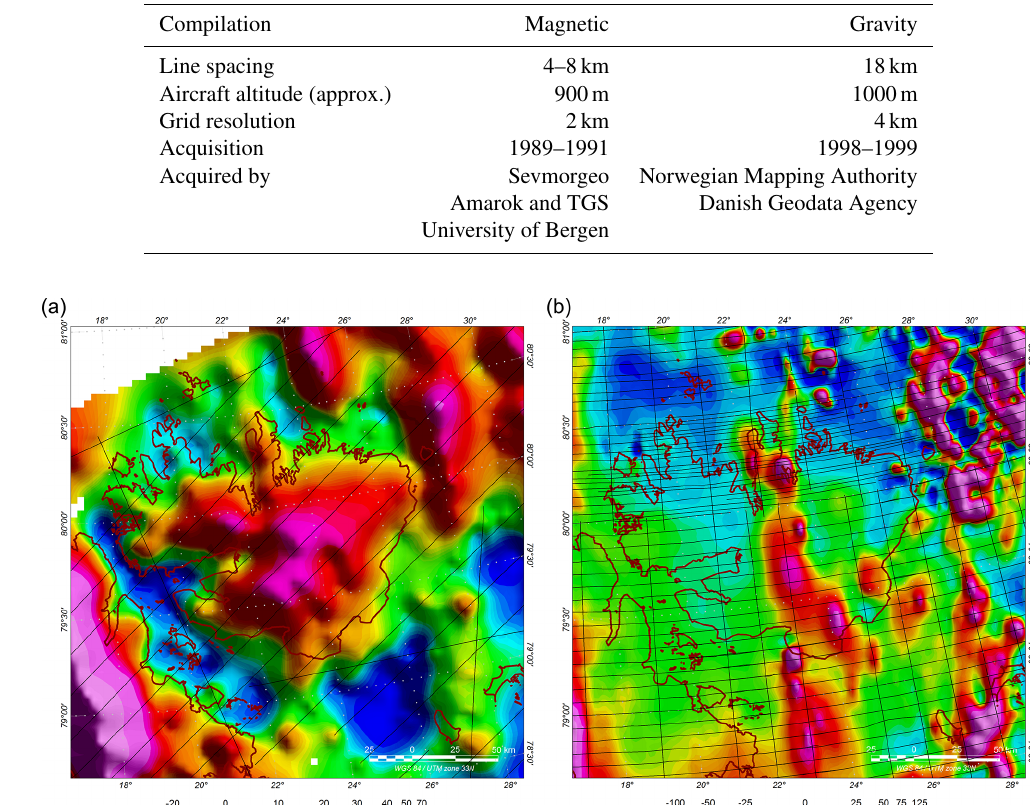
Figure 3. (a) Free-air gravity map and (b) a magnetic anomaly map of Nordaustlandet with the acquisition flight lines denoted by the thin black lines. The gravity data are sensitive to an excess or loss of mass. Low free-air gravity data are often linked to sedimentary basins. The magnetic data show important N–S-trending anomalies crossing Nordaustlandet and intersecting with the Caledonian Rijpfjorden